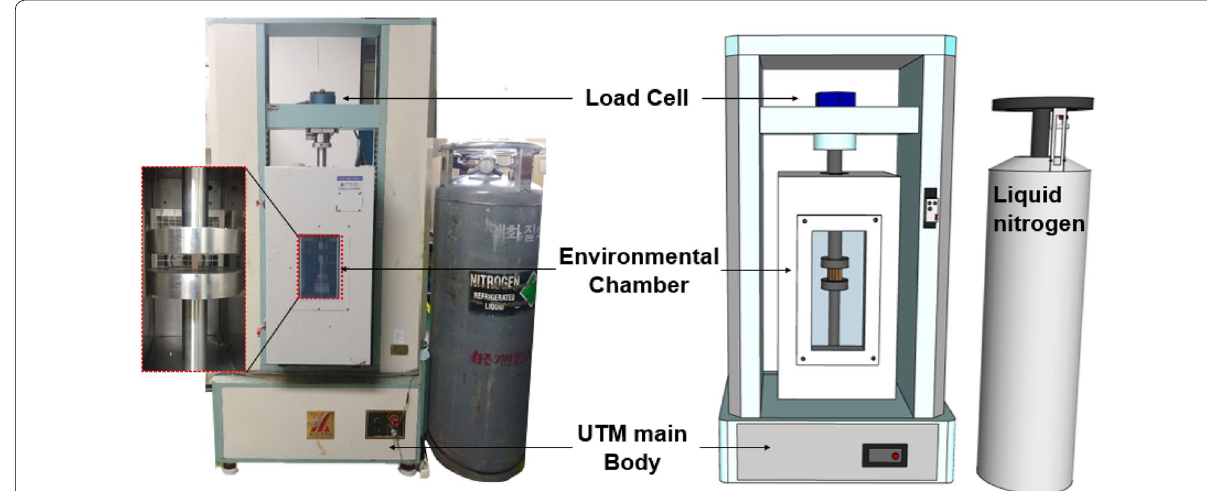
Fig. 5 Schematic diagram of the compression test machine